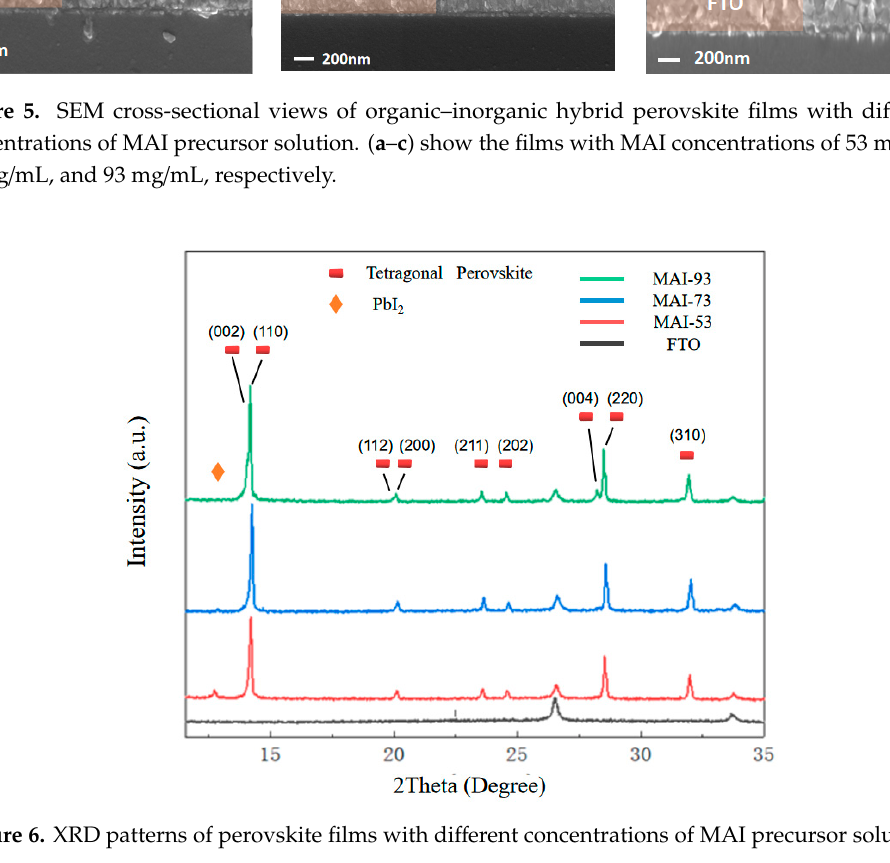
Figure 6. XRD patterns of perovskite films with di ff erent concentrations of MAI precursor solution.